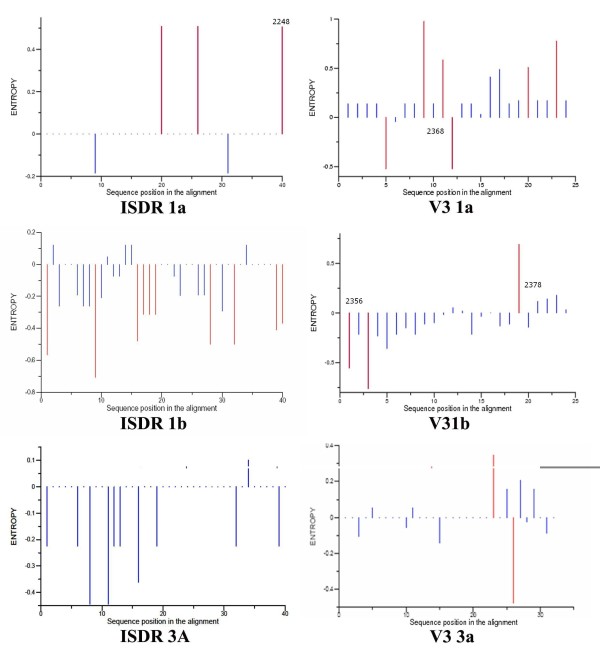
Relative Shanon entropy between non-responders & responders in the ISDR & V3 regions of subtypes 1a, 1b and 3a. It represents the difference between the positional entropy of the responders and non-responders (shown on the +ve and -ve scale respectively). It was calculated using the REL Entropy tool available from the great facilities at the HCV LANL database (significant positional variations between the two groups are labelled with red).